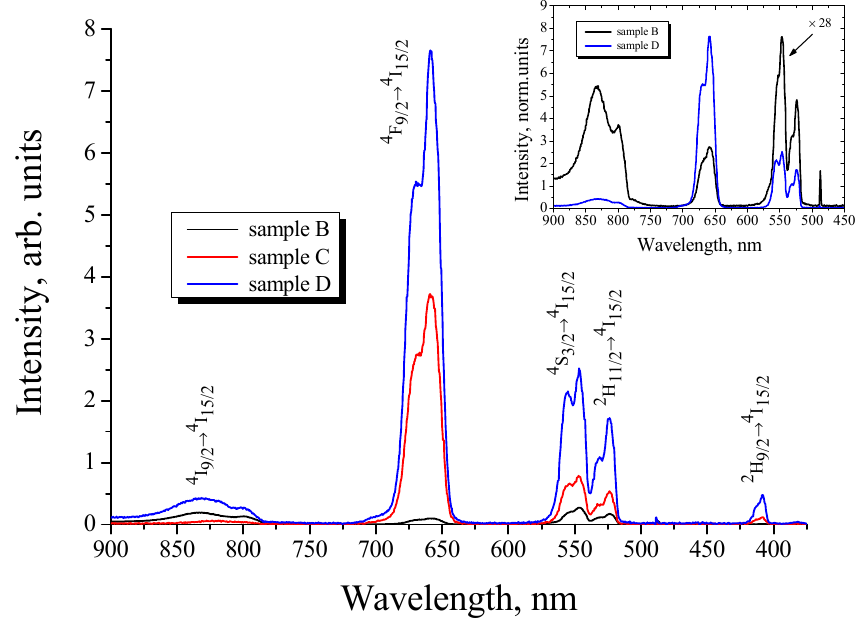
Figure 2. Upconversion PL spectra of BaTiO 3 :Er (sample B) and BaTiO 3 :(Er,Yb) (samples C and D) xerogel film structures on a Si substrate, taken under CW excitation at the wavelength of 980 nm. Samples B and D were obtained using an additional macroporous SrTiO 3 xerogel sublayer before the deposition of the active BaTiO 3 layer. Inset: comparison of the PL spectra of the samples B (multiplied by 28) and D.